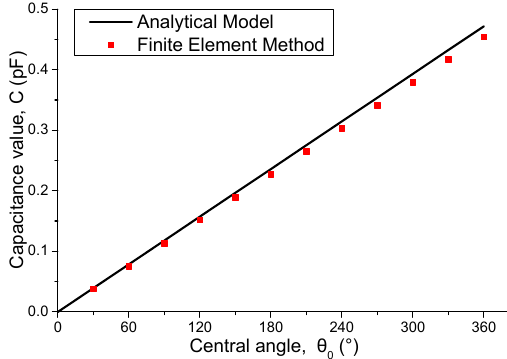
Figure 4. Capacitance values of the capacitors with different central angle θ 0 .